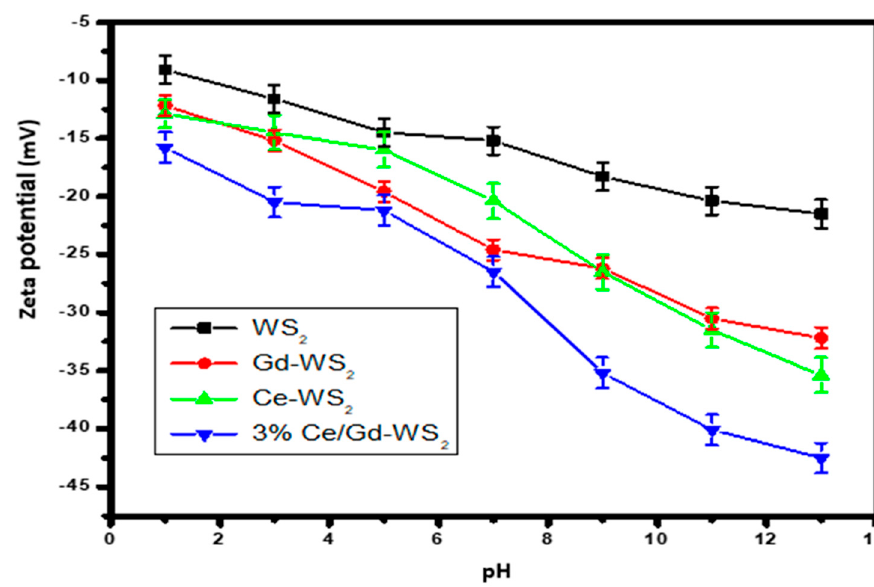
Figure 1. Pristine, metal doped, and co-doped WS 2 zeta potential.